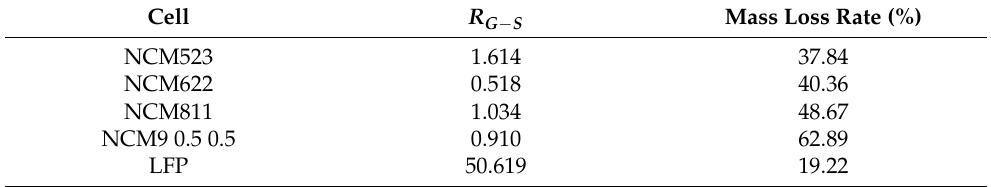
Table 6. TR mass loss rate and 𝑅 𝐺−𝑆 of battery.